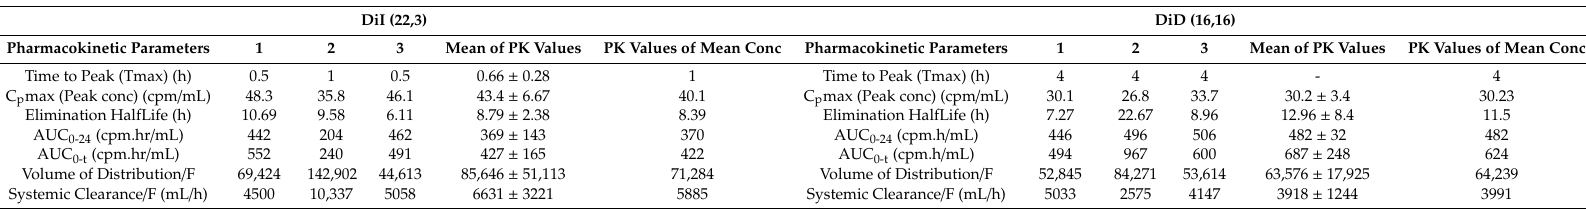
Table 2. Pharmacokinetic properties of 125 I-DiI (22,3)- and DiD (16,16)-SapC-DOPS. The compounds were radioiodinated as described in Materials and Methods, incorporated into SapC-DOPS nanovesicles and injected into nude mice. Blood was taken at 0, 0.5, 2, 4, 6 and 24 h and measured for radioactivity. The numbers in the top row indicate the number of the